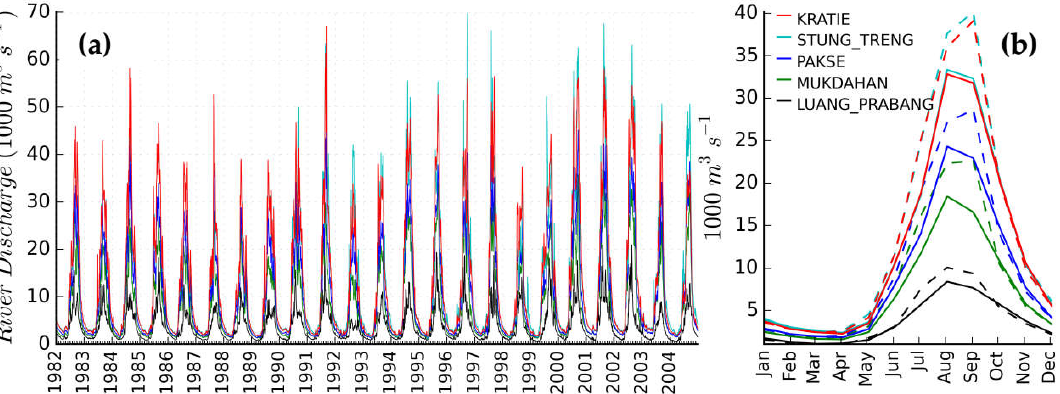
Figure 2. Observed daily river discharge ( a ) for five gauging stations in the main stem of the Mekong which are shown in Figure 1, and the monthly seasonal cycle ( b ) for 1982–1992 (solid lines) and 1993–2004 periods (dashed lines). Data source: the Mekong River Commission (MRC).